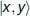
Quantum circuit to simultaneously evaluate f(x).
Uf is the quantum circuit that takes inputs, such as |x,y〉, to |x,y⊕f(x)〉.